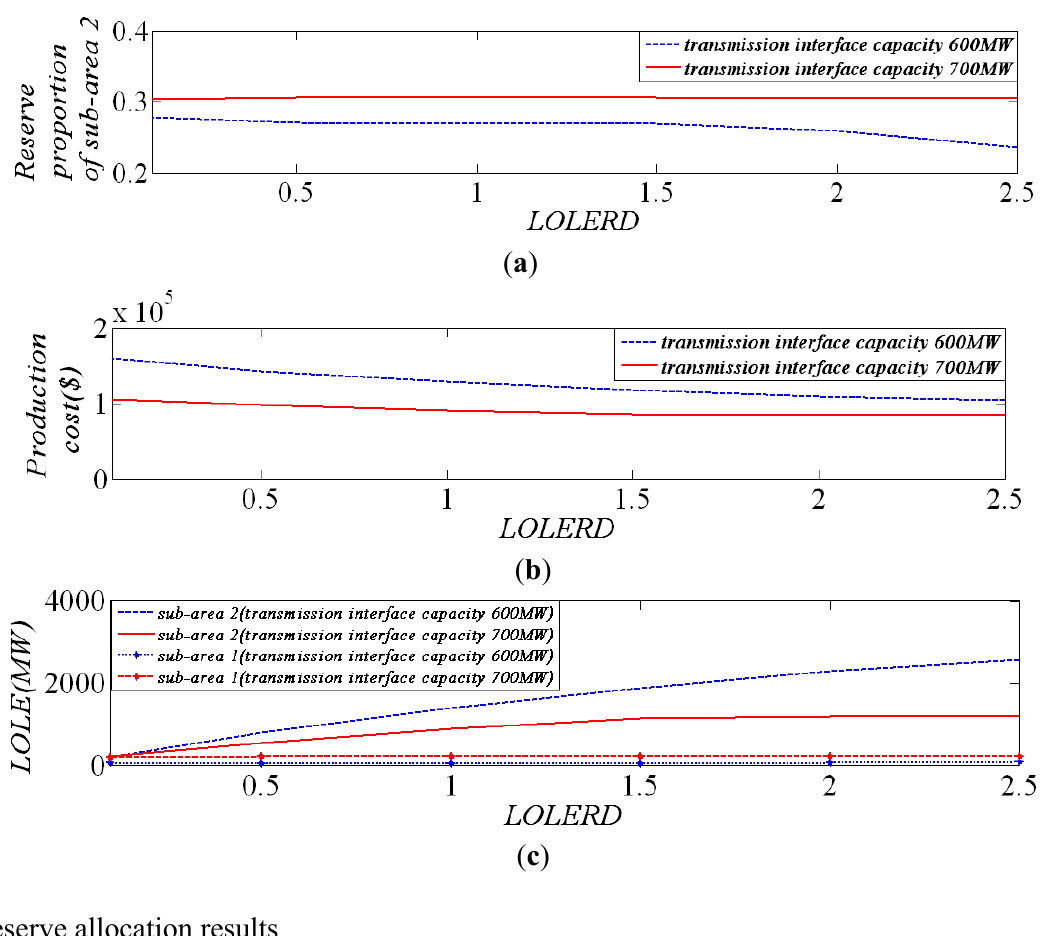
Figure 9. Results with different transmission interface limits. ( a ) Relationship between reserve proportion of sub-area 2 and LOLERD; ( b ) Relationship between the production cost and LOLERD; ( c ) Relationship between sub-area LOLE and LOLERD.